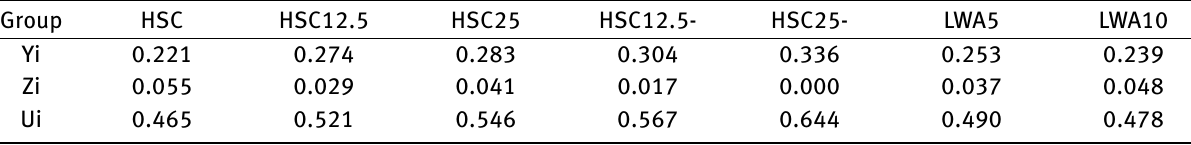
Table 7: Ranking of each test group by overall performance Group HSC HSC12.5